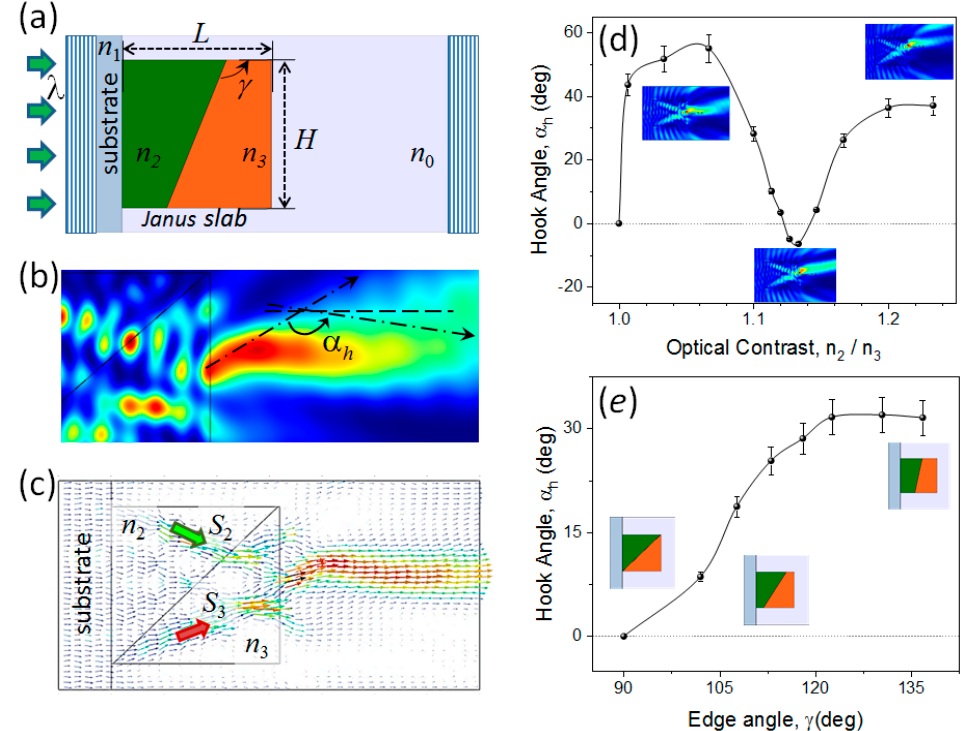
Figure 5. Photonic hook from a Janus slab ( L × H = 3.2 × 3 λ 2 ) exposed to a 500-nm plane wave [59]: ( a ) geometrical scheme, ( b ) intensity map and ( c ) energy fluxes vector map. Hook angle dependence on ( d ) optical contrast and ( e ) slab edge angle.